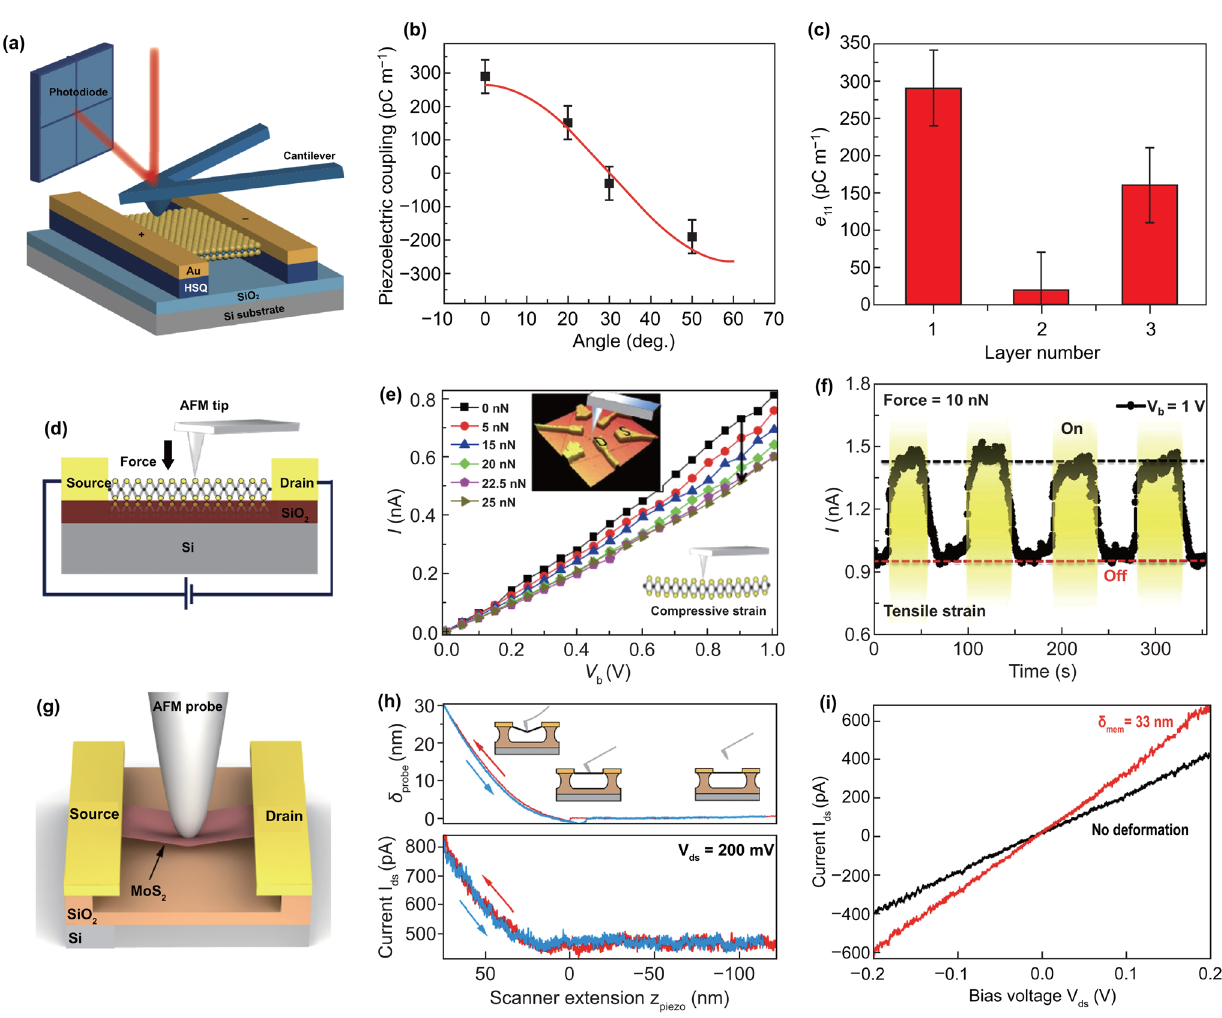
Fig. 11 Applied strain to 2D semiconductors by AFM tip. a Schematic drawing of measuring piezoelectric property of monolayer MoS 2 by using an AFM probe. b Measured piezoelectric coupling strength as a function of the crystal’s azimuthal angle θ . c Measured piezoelectric coef- ficient in one-, two- and three-layer MoS 2 . Reproduced with permission [169]. Copyright 2014, Nature Publishing Group. d Schematic illustra- tion of the measurement setup. e I – V characteristics of the MoS 2 device at different applied forces. f Current response of CVD monolayer MoS 2 device at repeated force at a fixed bias voltage of 1 V. Reproduced with permission [170]. Copyright 2015, Nature Publishing Group. g Sche- matic drawing of the experiment setup for electrical performance characterization of a suspended MoS 2 devices under the strain applied by AFM tip. h Cantilever deflection and the drain current of the device as a function of the piezo-scanner extension. i I – V curve of the device under the strain by AFM tip and without deformation. Reproduced with permission [171]. Copyright 2017, American Chemical